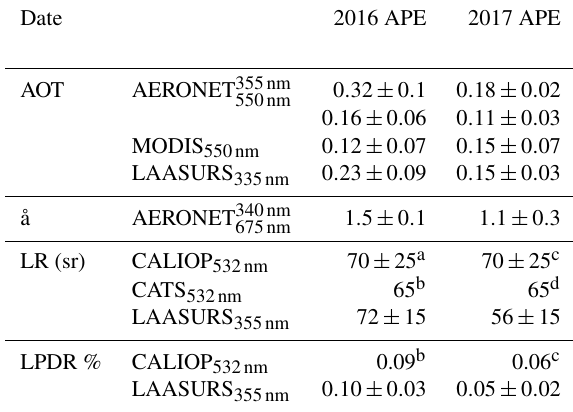
Table 3. Optical properties encountered during the two most pol- luted days of the winter